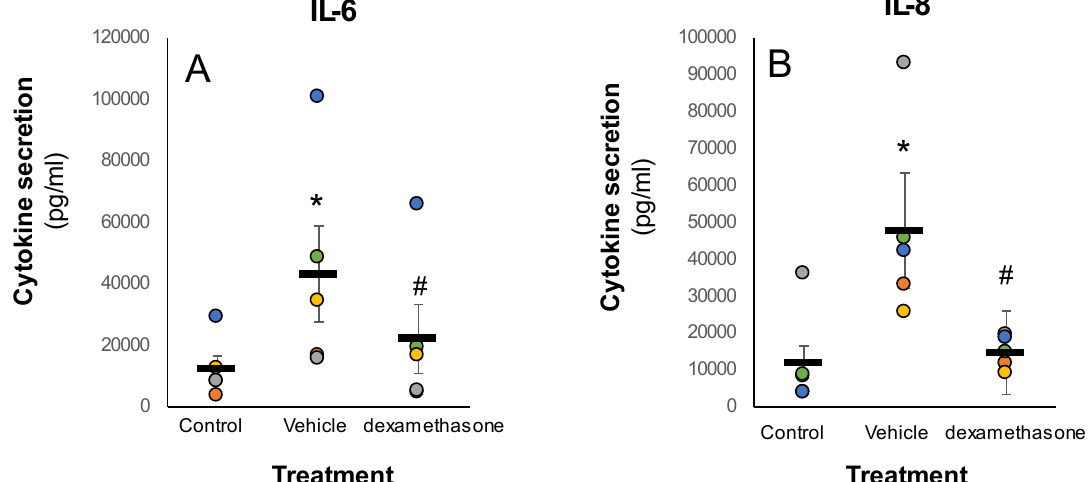
Figure 3. Dexamethasone attenuated LPS-induced cytokine secretion in the human skin organ culture. The skin explants were treated without or with LPS for 48 h (5 µ g / mL). The secreted levels of IL-6 ( A ) and IL-8 ( B ) in the human skin organ culture were quantified by ELISA. Results are shown as MEAN ± SEM, n = 5. * / # P < 0.05 for di ff erence from the untreated control group or LPS-stimulated (vehicle) group, respectively.